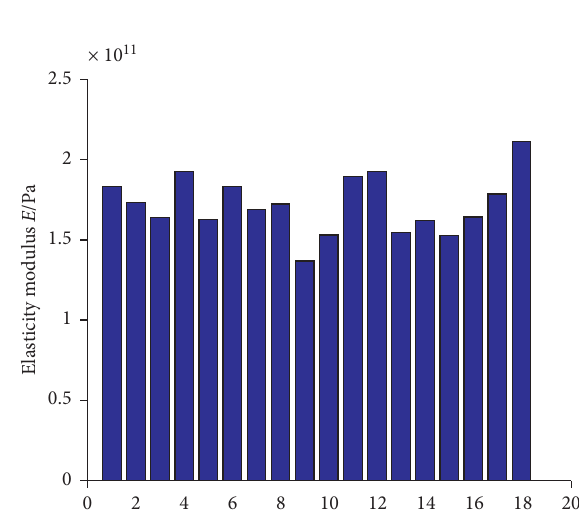
Figure 1: Blade thickness.